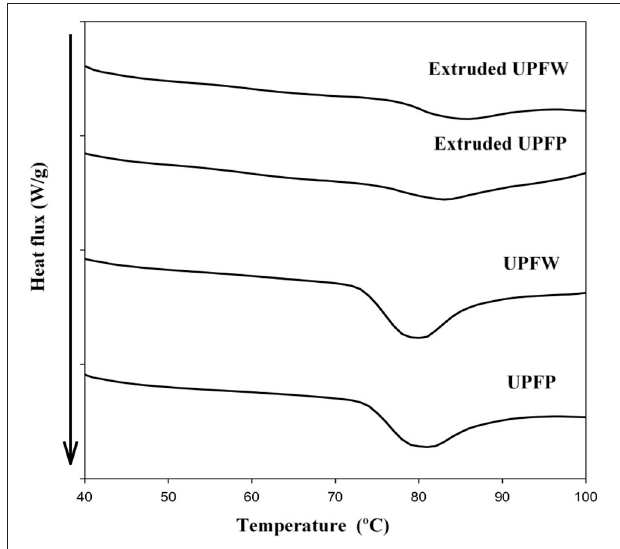
FIGURE 1 | Differential scanning calorimetry of native and extruded flours of unripe plantain pulp (UPFP) and whole fruit (UPFW).